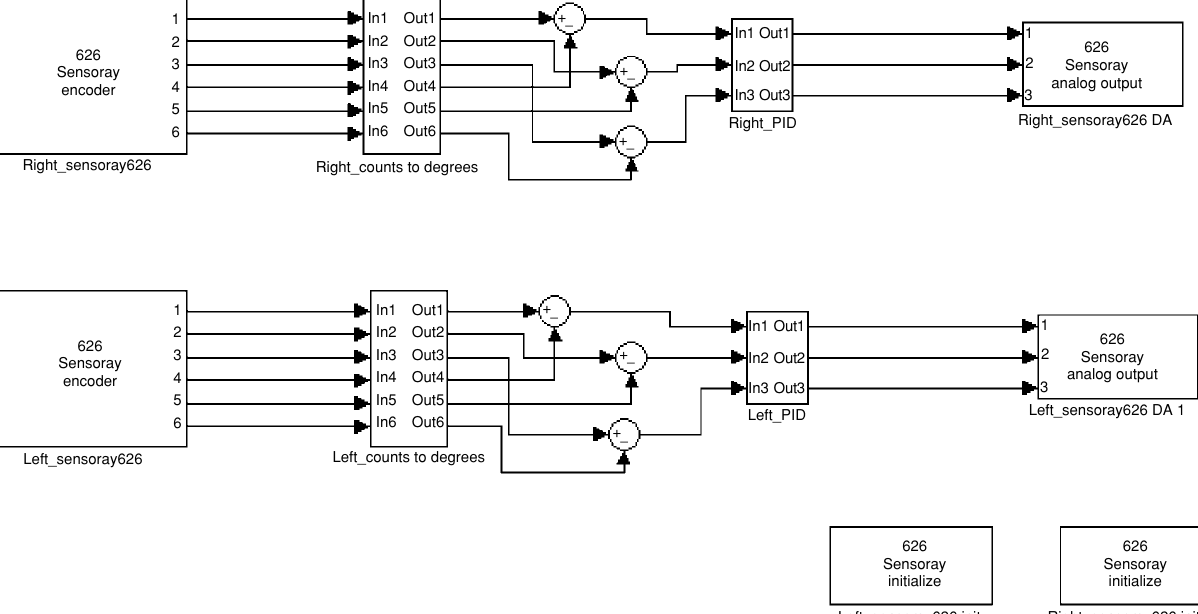
Figure 23 Scheme of LEE with controller for testing. 4. Executive control level executes the required motion of each